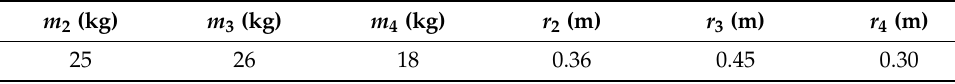
Table 1. Link properties of the 4-link manipulator.